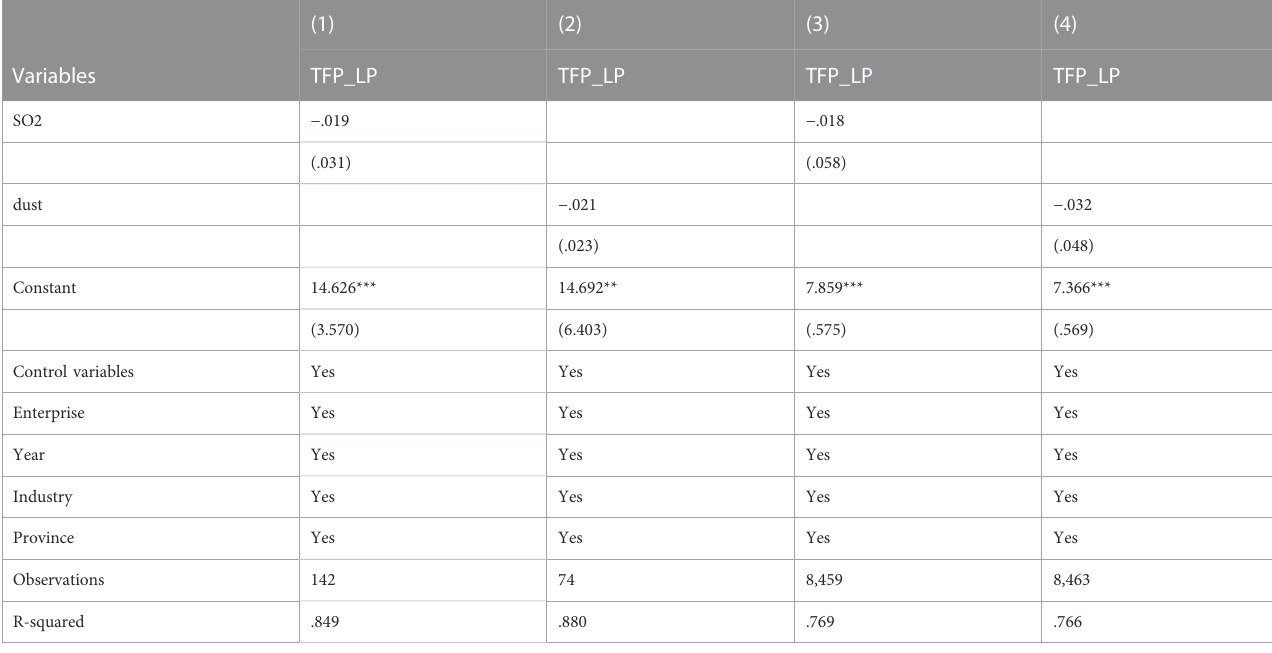
TABLE 8 Heterogeneity: Pollutant type.